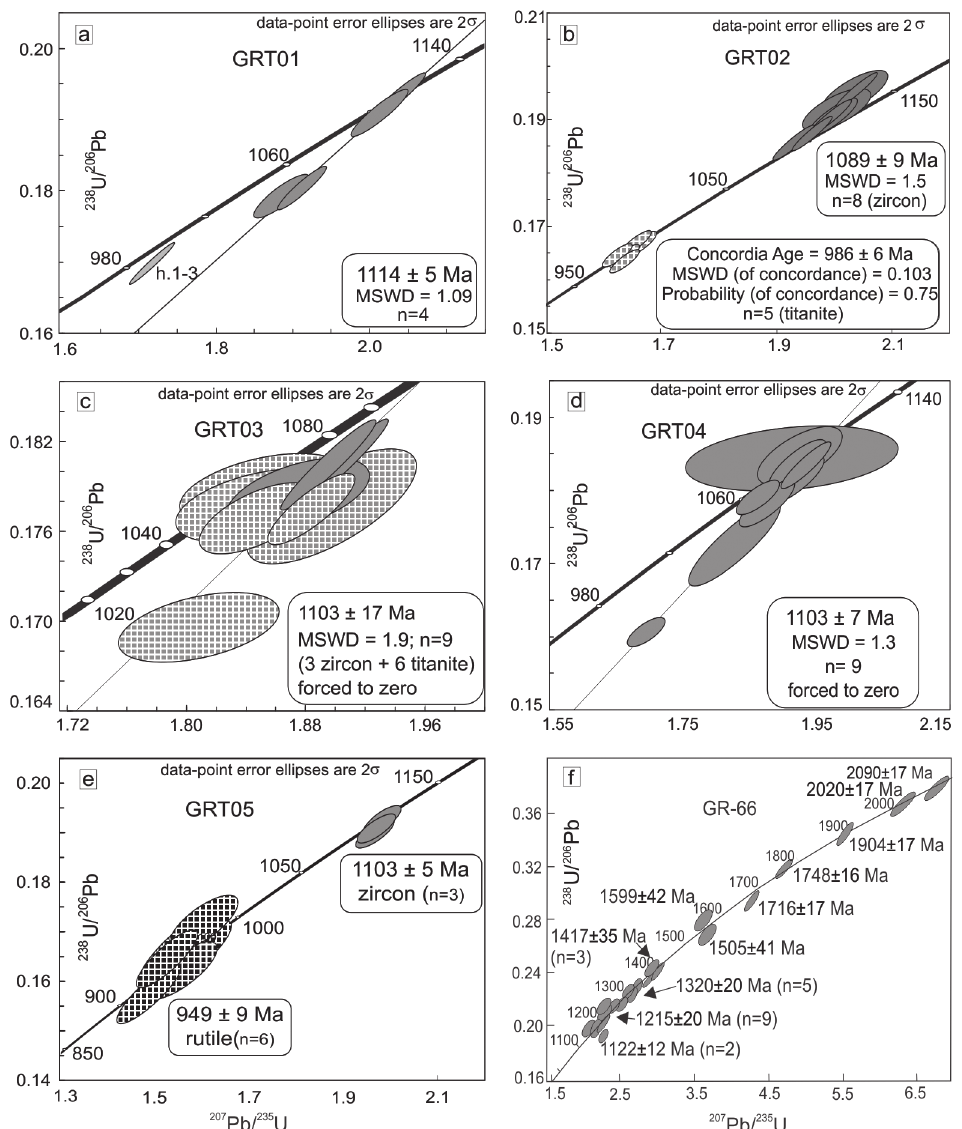
Figure 4 - Concordia diagrams of dated samples of the Nova Brasilândia